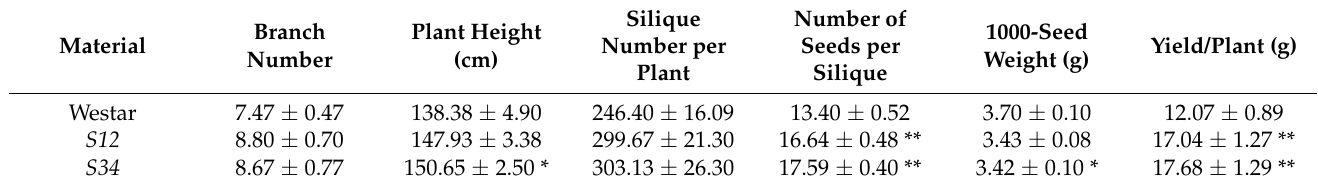
Table 1. Statistics of agronomic characters of three lines grown in Cd-contaminated